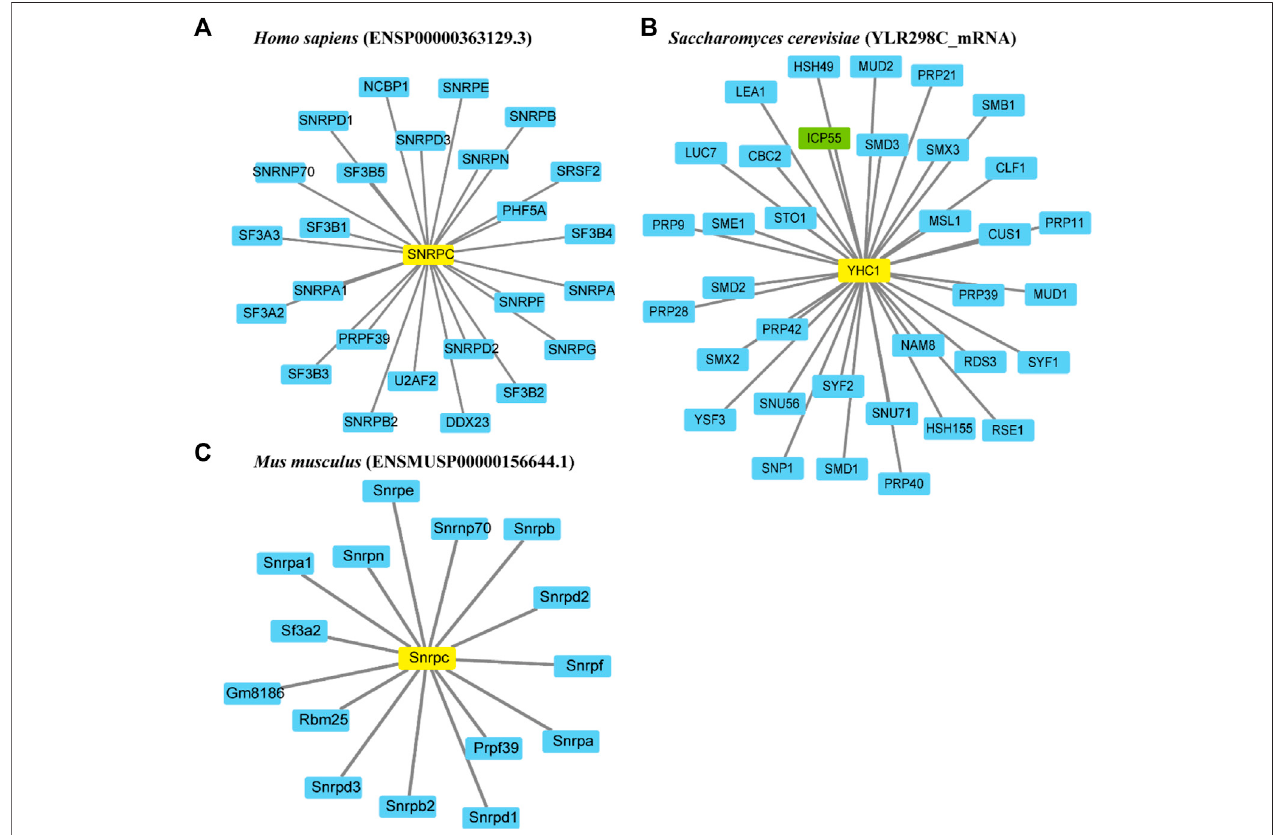
FIGURE 3 | Representative protein-protein interaction networks of Homo sapiens , Mus musculus and Saccharomyces cerevisiae . Interaction networks of U1Cs (highlighted in yellow) of (A) human (ENSP00000363129.3), (B) mouse (ENSMUSP00000156644.1) and (C) yeast (YLR298C_mRNA) are carried out by Cytoscape 3.8 softwarebased onexperiments and databasesfrom STRING database.Interactorsinvolved insplicingarehighlighted inblue, while ICP55 as theonly genenot involved in splicing is shown in green. Minimum required interaction score (combined score): 0.900.